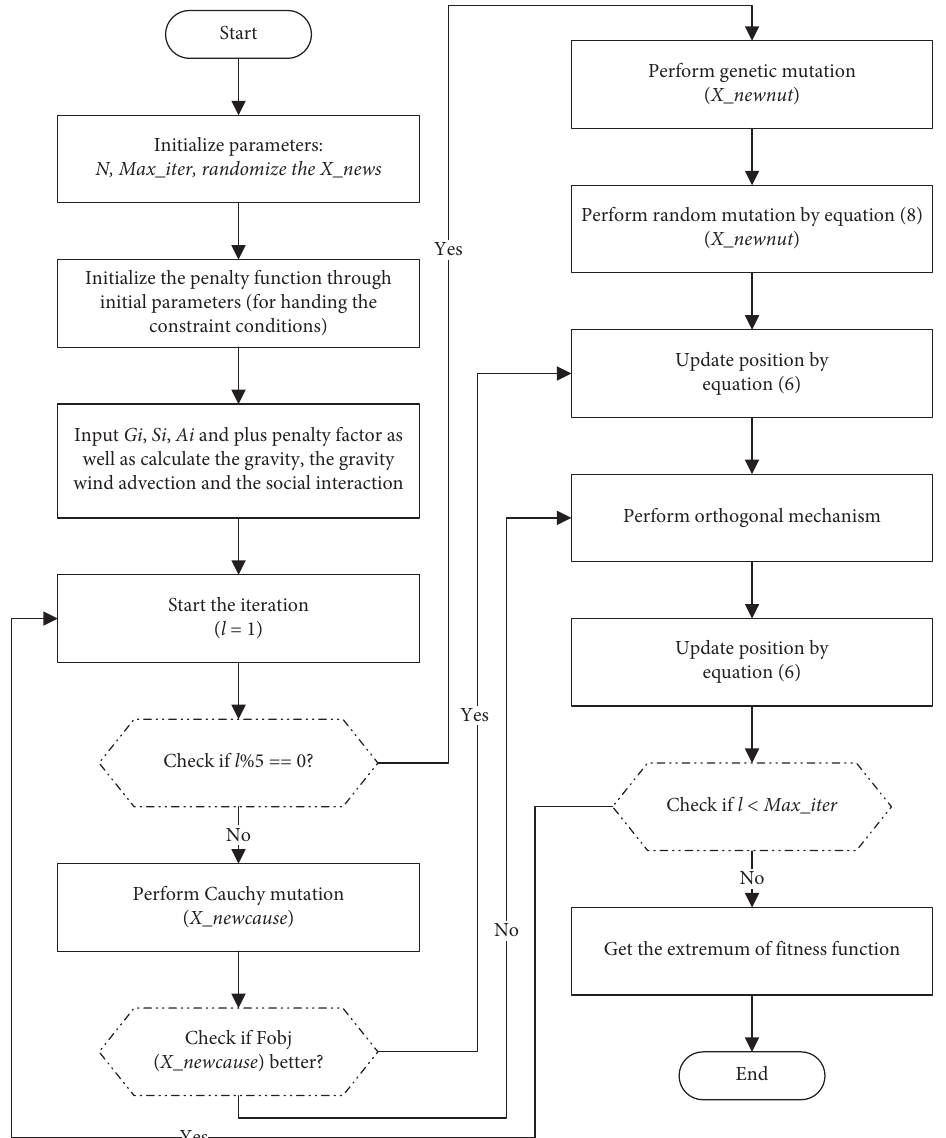
Figure 4: The flowchart of MOLGOA for constraint optimization. X new is the position of the grasshopper, l is the current iteration, N is the population and the X newcause is the position after the mutation operation.